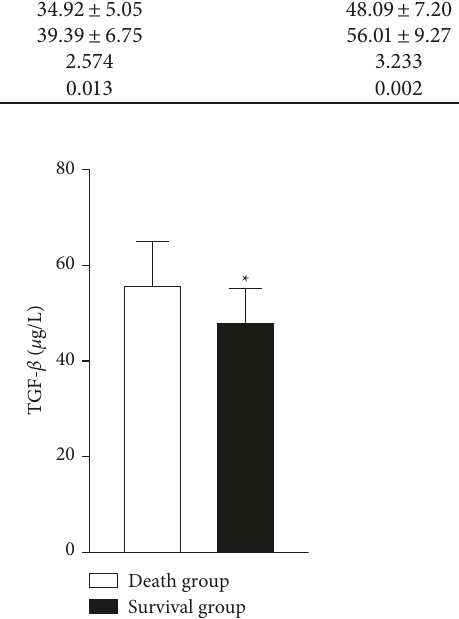
Table 4: Comparison of the levels of CD4 +CD25+Treg, IL-10, and TGF- β between survival group and death group ( x ± s ). Group